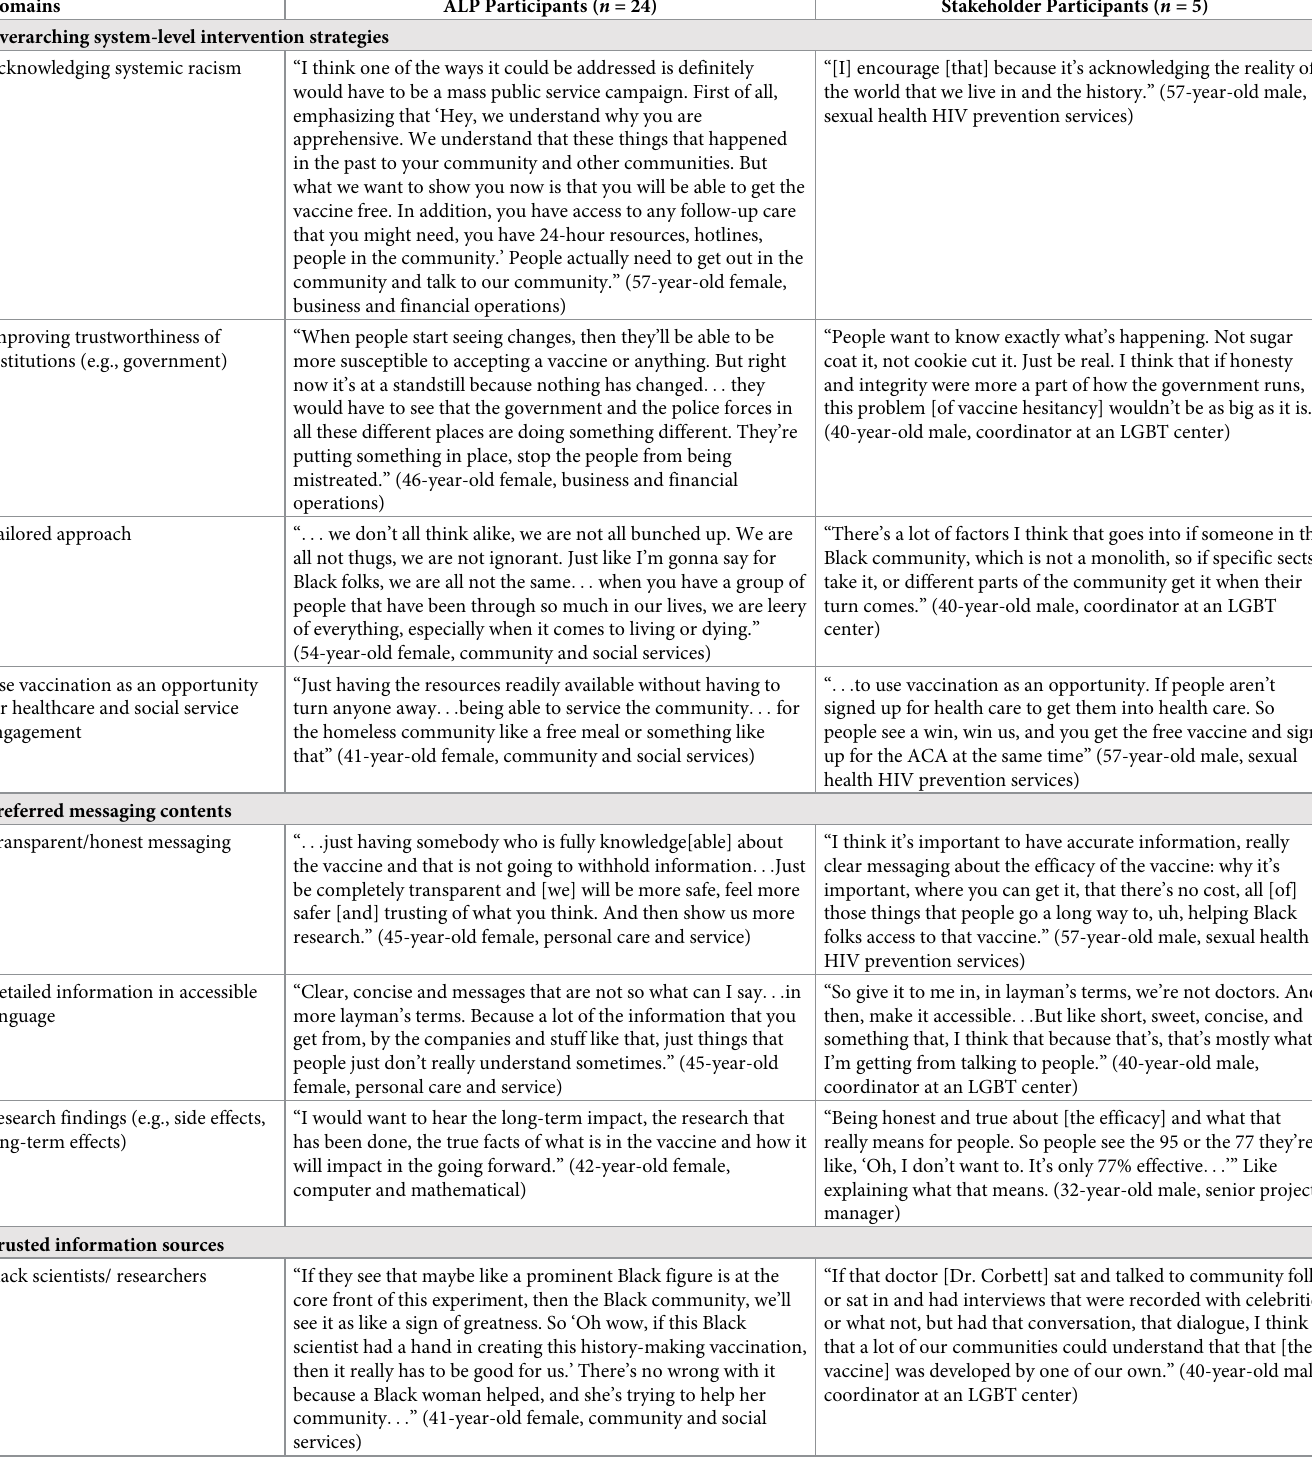
Table 4. System-level interventions strategies to promote COVID-19 vaccines from semi-structured interviews ( n = 29).